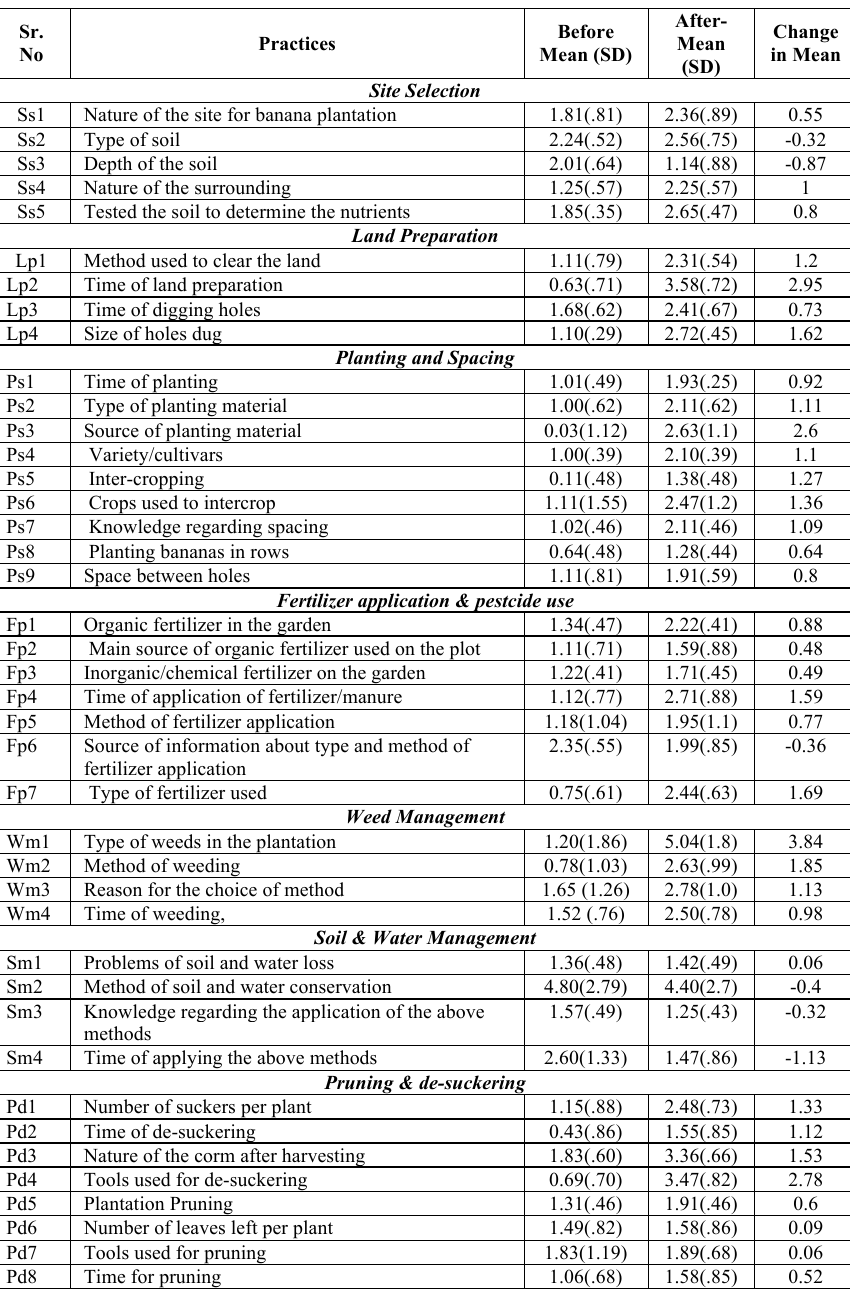
Table 1. Knowledge gain by smallholder banana farmers before and after the intervention of audio